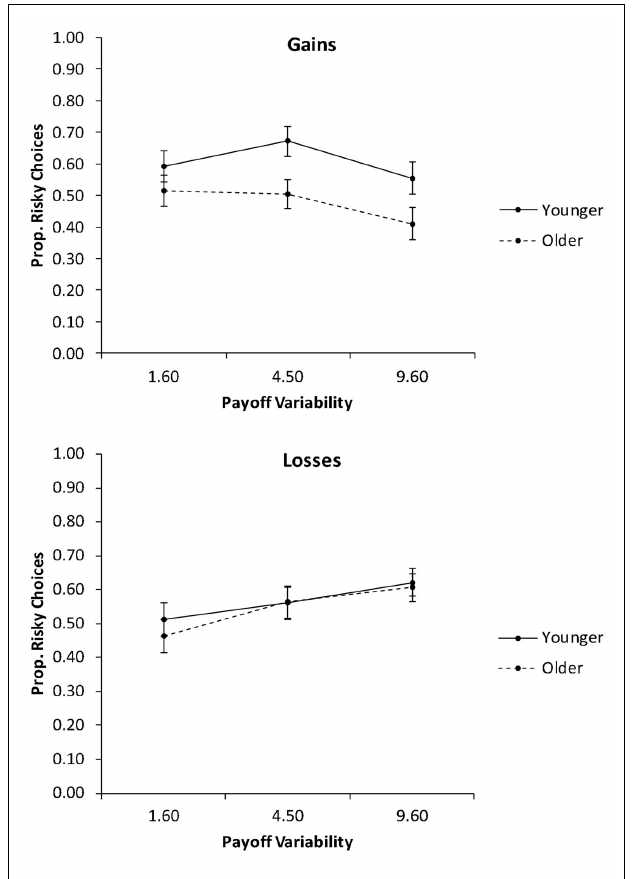
FIGURE 5 |The proportion of risky choices as a function of valence and the payoff variability, for younger and older adults. Adjusted means for the average level of the covariate (years of education) are shown. Error bars show the